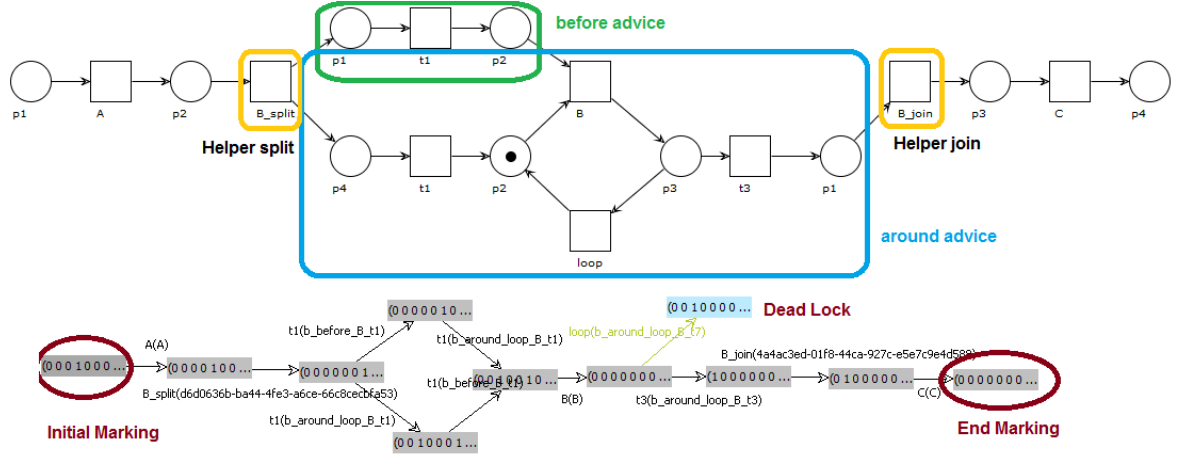
Figure 9. Weaving the sample scenario